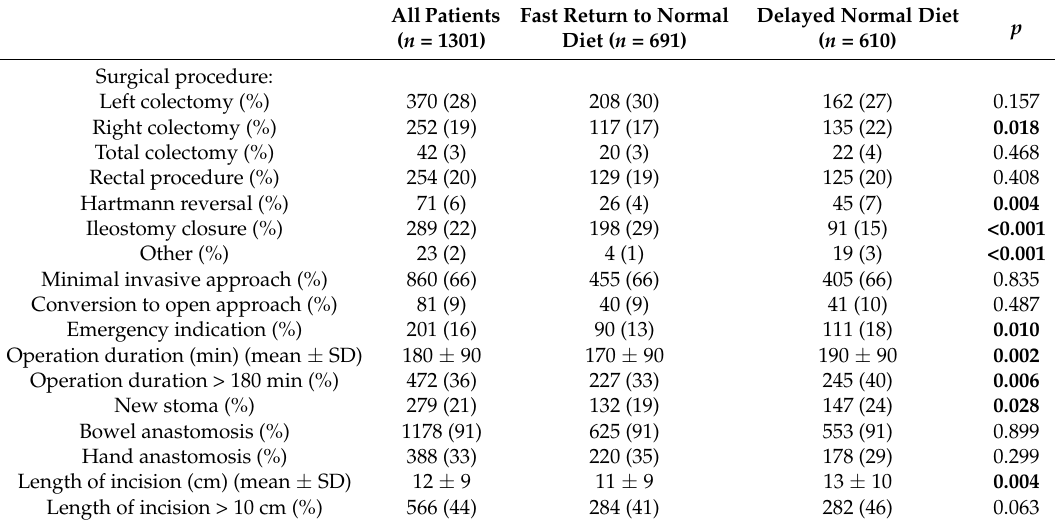
Table 2. Surgical